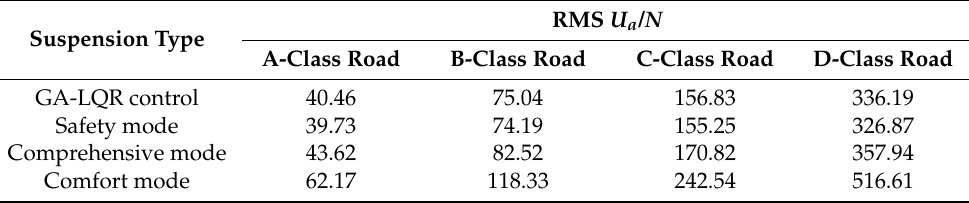
Table 12. RMS values of power consumption of each suspension type under different roads.